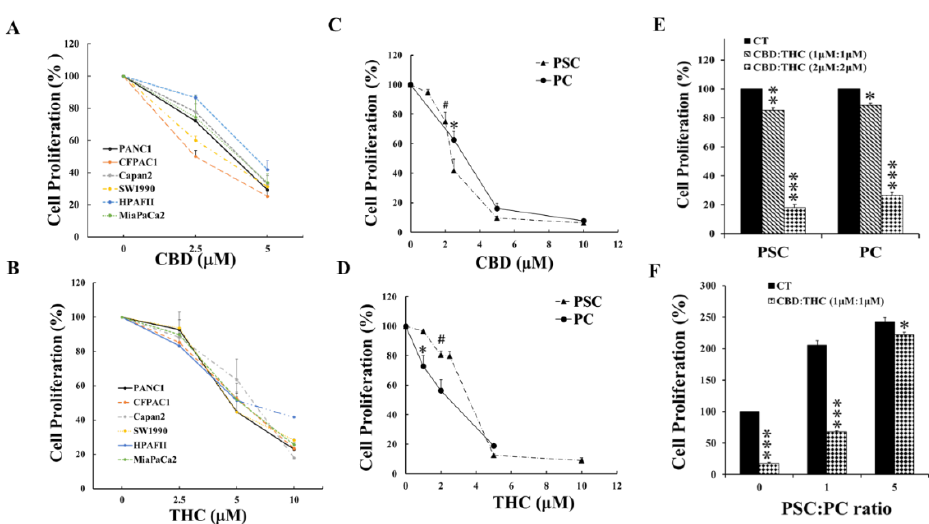
Figure 1. CBD and THC suppressed proliferation of PC, PSC, and PSC-stimulated PC cells. A panel of human pancreatic cancer (PC) cells were treated with CBD ( A ) and THC ( B ) for 48 h and cell proliferation was measured by MTT assay as described in the Materials and Methods. Murine PC and pancreatic stellate cells (PSC) were also treated with CBD ( C ) and THC ( D ) for 48 h and cell proliferation was measured by MTT assay. Either PC or PSC cells were treated with CBD and THC at 1:1 ratio as indicated in graph ( E ) for 48 h and cell proliferation was determined by MTT assay. Murine PC (luciferase-labelled) and PSC cells were mixed at the ratios indicated in graph ( F ) and incubated with CBD plus THC at 1:1 ratio, and PC cell proliferation was determined by luciferase activity. The values from non-treated controls were taken as 100%. The data were summarized from three independent sets of experiments. # or *, p < 0.05; **, p < 0.01; ***, p < 0.001 compared to related control. CT: control.